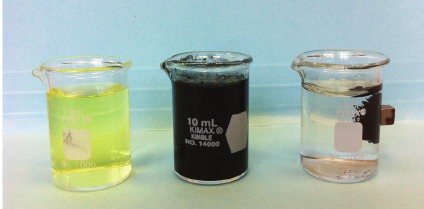
Figure 3: Adsorption experiment. From left to right: dissolution of tartrazine, mixture of tartrazine with magnetic modified carbon, and magnetic support